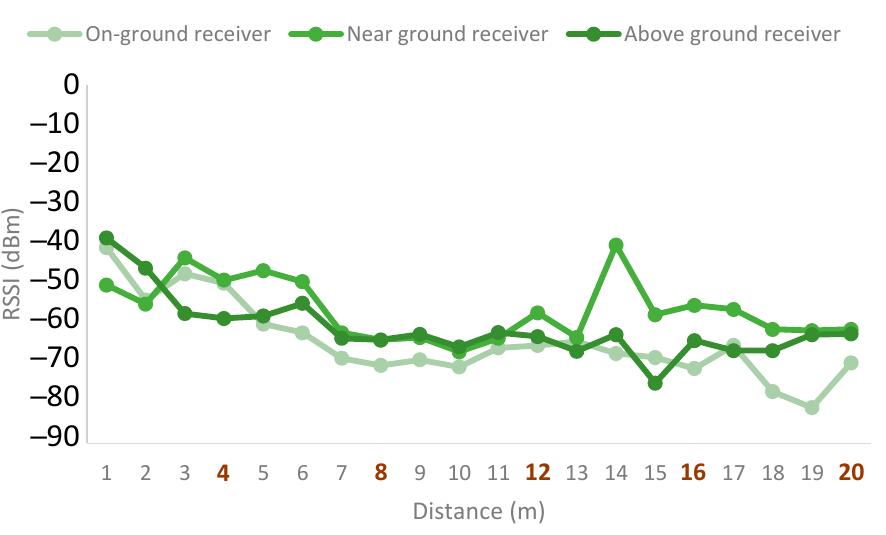
Figure 15. Emitter at height of 1 m.